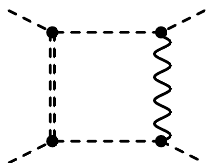
(cid:12)elds are not displayed, because (cid:22)